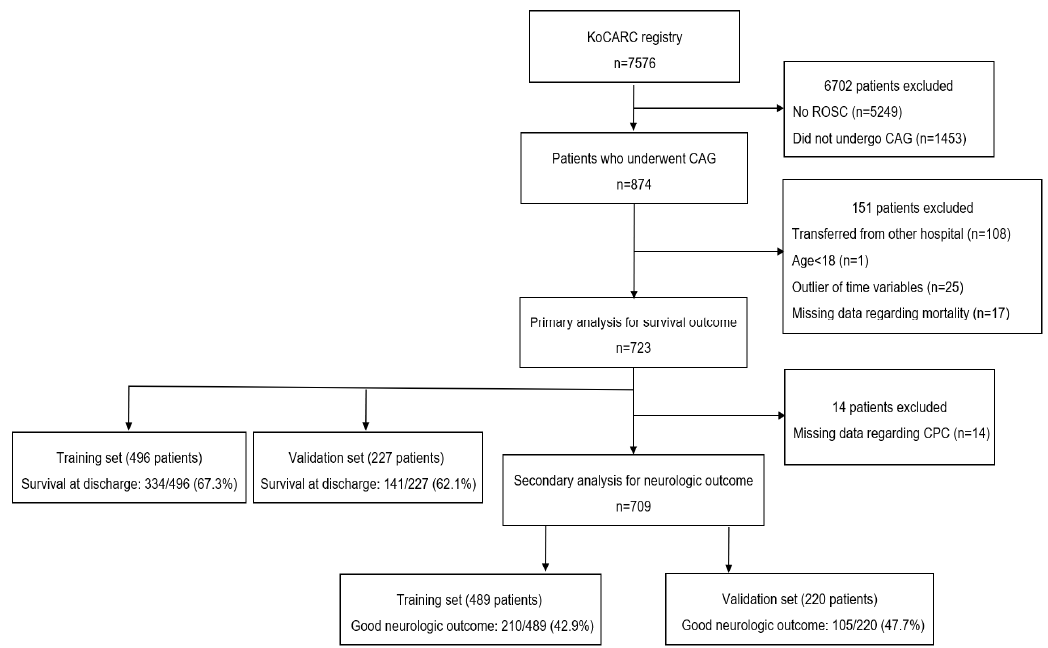
Figure 1. Patient flowchart. Abbreviations: KoCARC: Korean Cardiac Arrest Research Consortium, ROSC: return of spontaneous circulation, CAG: coronary angiography, CPC: cerebral performance category.